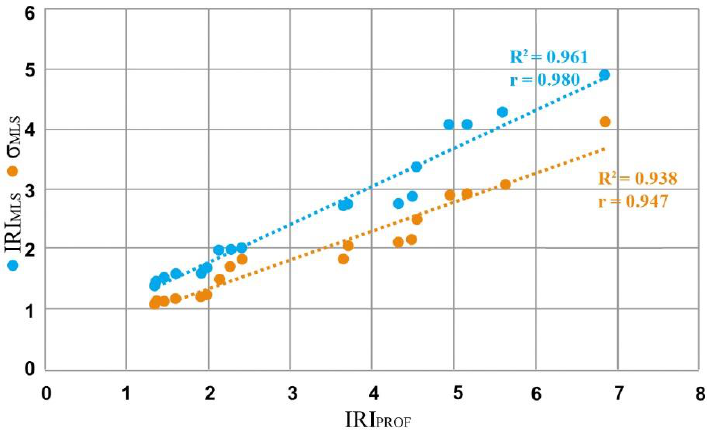
Figure 9. Correlation between IRI PROF , IRI MLS , and σ MLS .